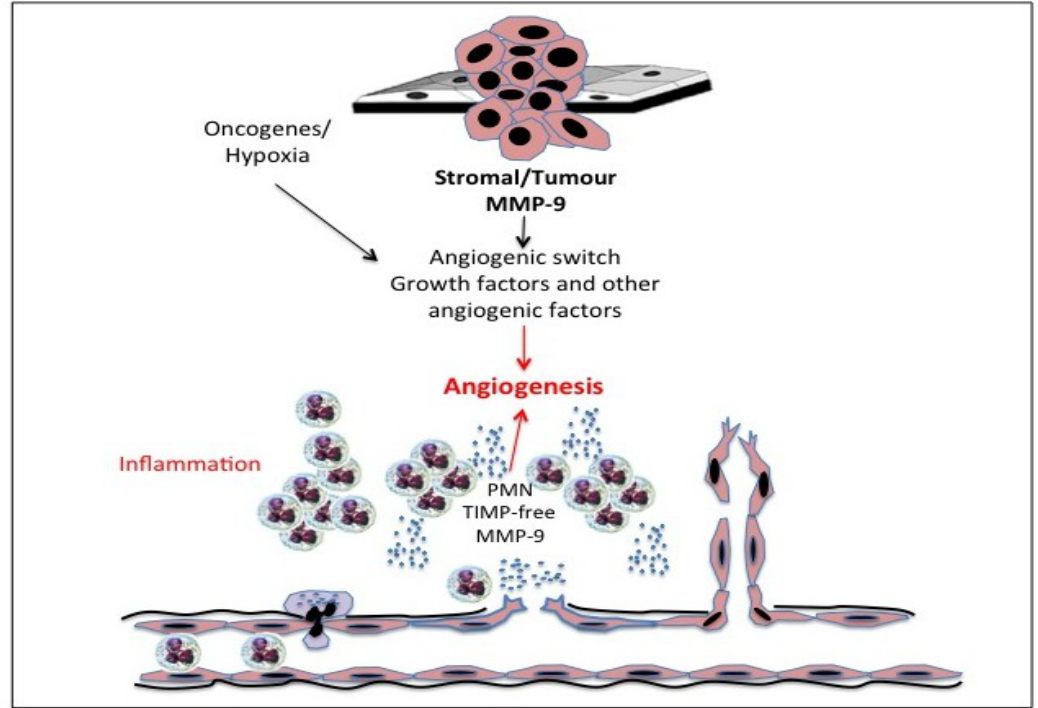
Figure 4. Representation of the roles played by inflammatory polymorphonuclear leukocyte (PMN)-derived tissue inhibitor of metalloproteinase (TIMP)-free gelatinase B/MMP-9, gelatinase B/MMP-9 of stromal and tumour origin, oncogenes and hypoxia in activating the tumour angiogenic switch required for tumour